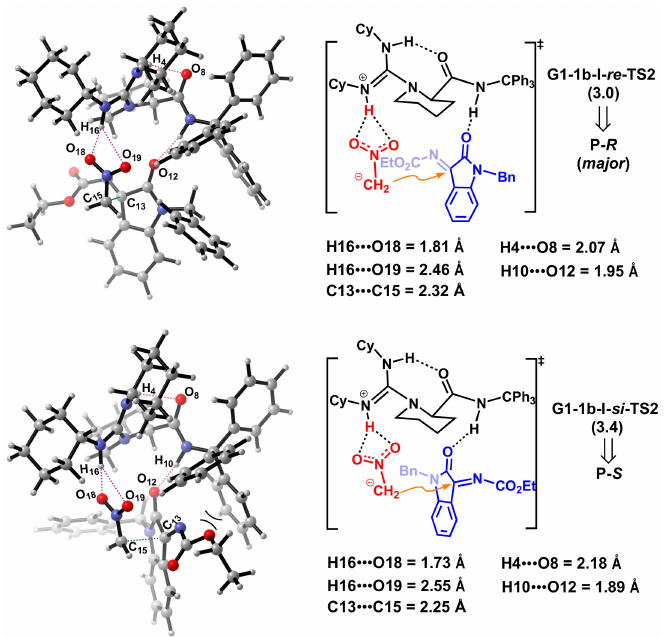
Figure 6. Optimized structures and the relative Gibbs free energy (kcal · mol − 1 ) of transition states G1-1b-I- re -TS2 and G1-1b-I- si -TS2 in the C–C bond formation step in the aza-Henry reaction between ketimine (R1b) and nitromethane (R2) catalyzed by guanidine